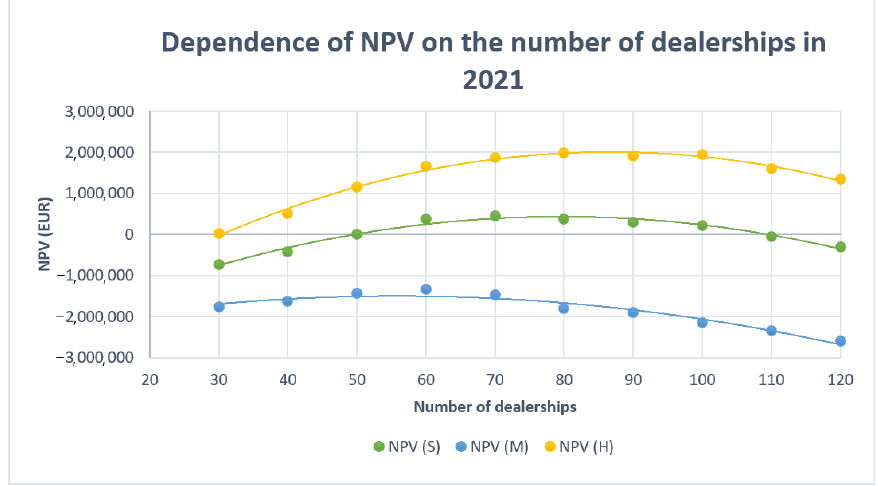
Figure 9. Dependence of NPV on the number of dealerships of the small battery storage strategy.